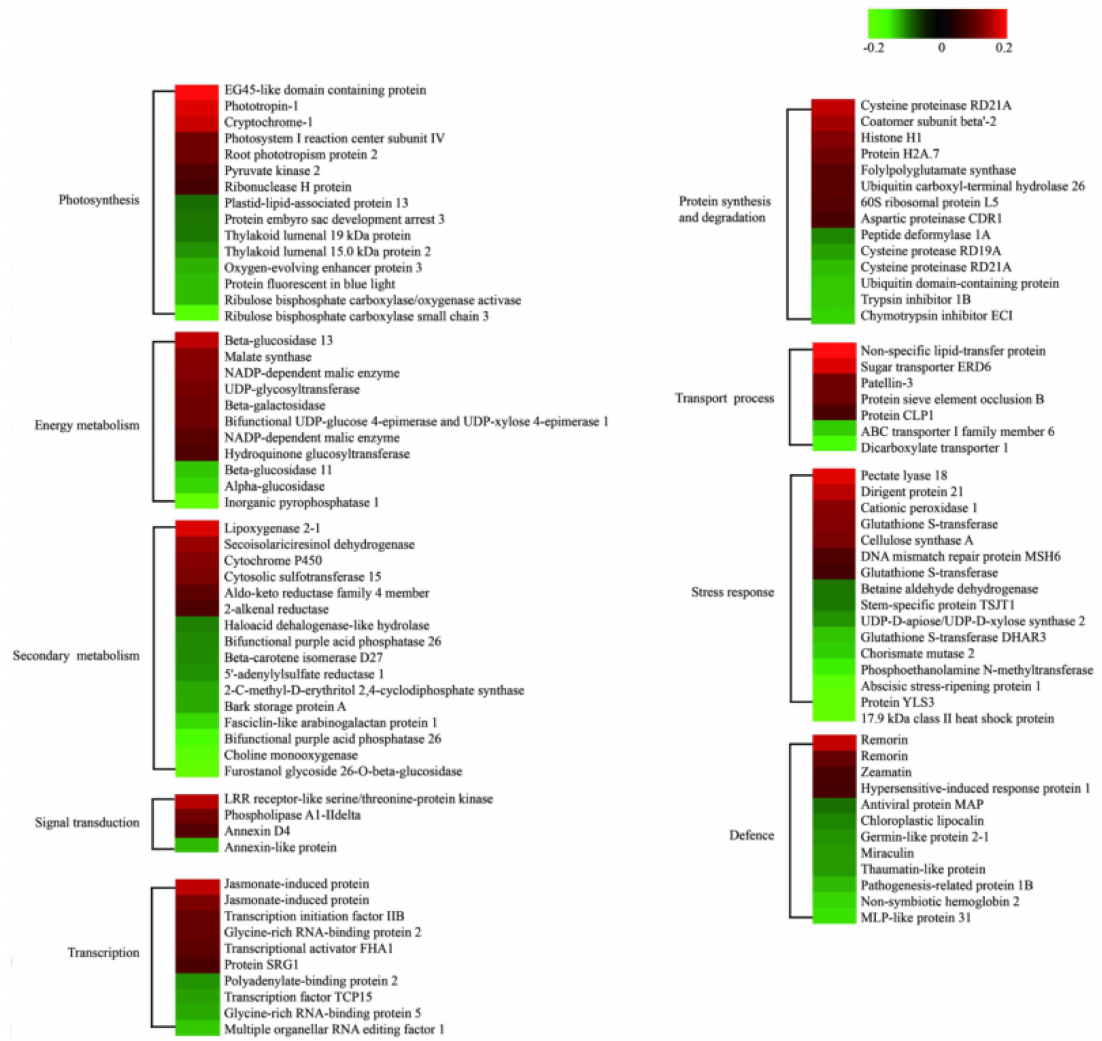
Figure 4. Enrichment results of DAPs by KEGG analysis. Note red indicates increased protein abundance; green indicates decreased protein